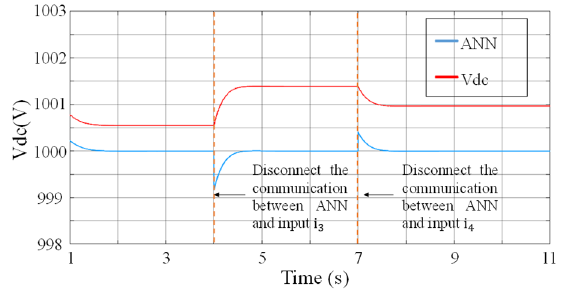
Figure 9. Values of DC bus voltage and ANN output in case study 5.